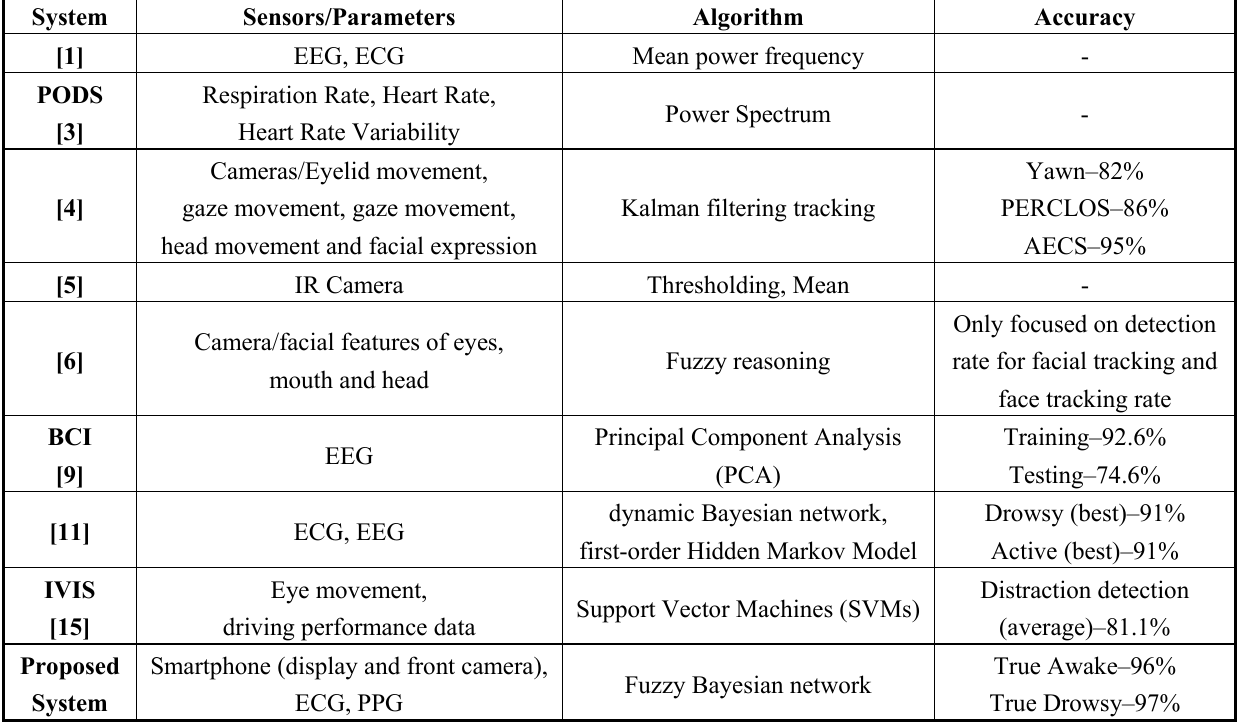
Table 3. Overview of existing drowsiness detection